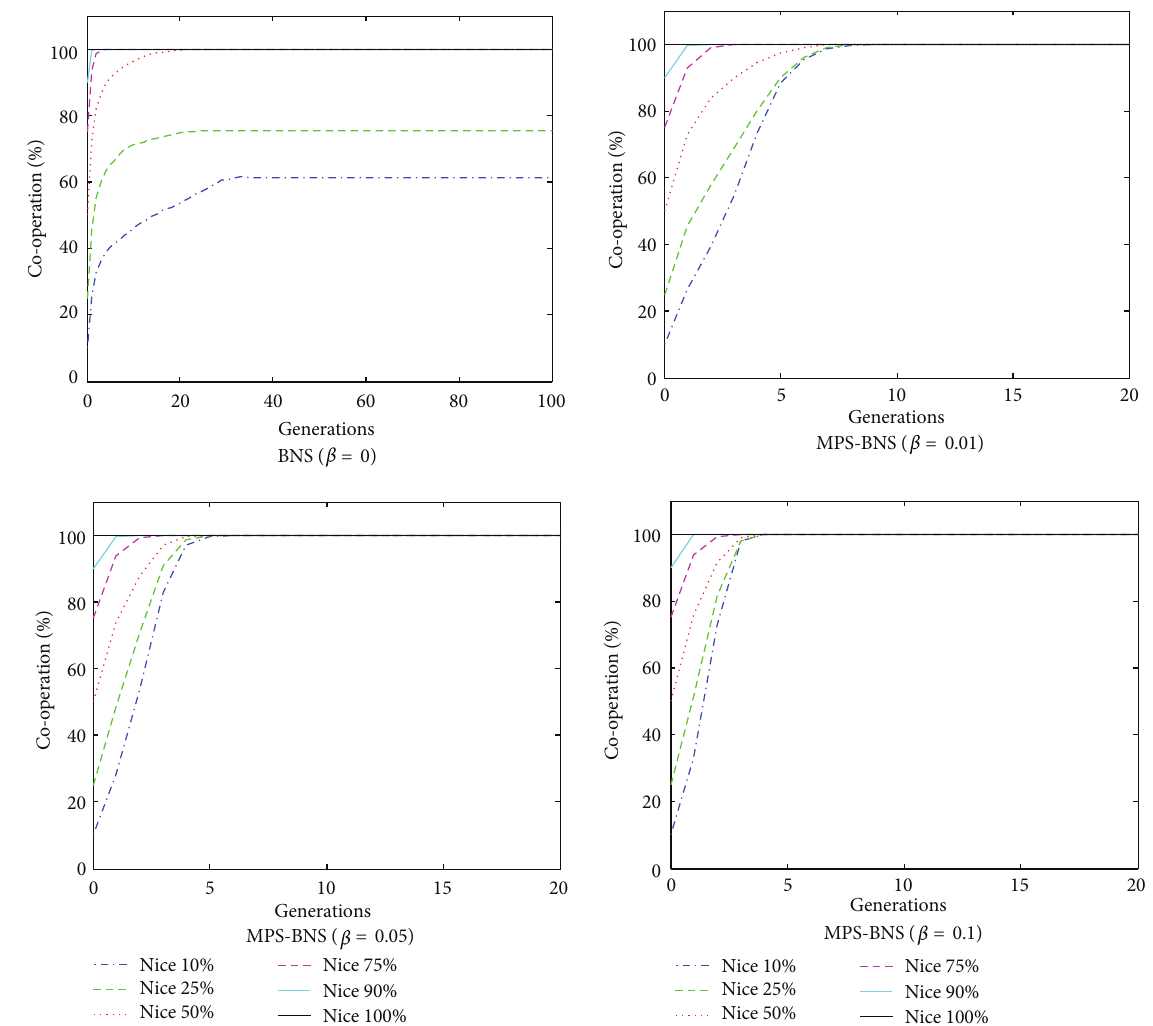
S 7: e Percentage of cooperation of evolution of MPS-BNS with mixed strategy pro�le.